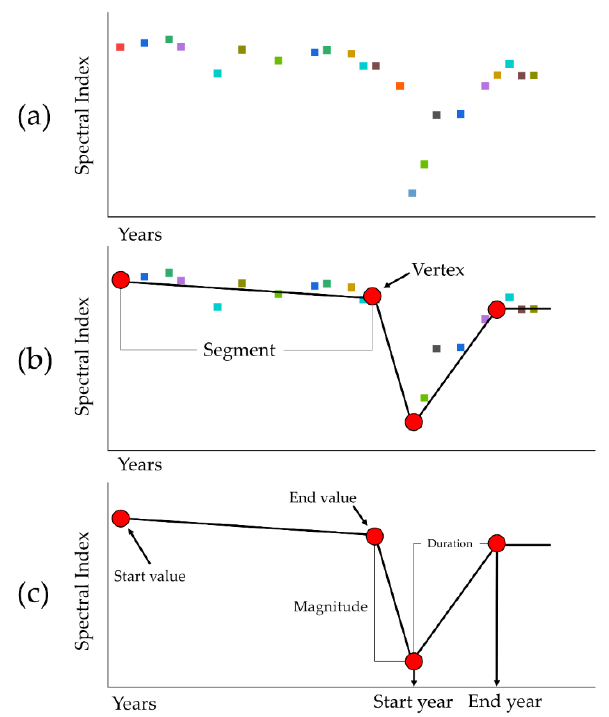
Figure 6. LandTrendr pixel time-series segmentation [42]. ( a ) Time series of individual bands or spectral indicators of image elements. ( b ) Segmentation into a series of linear segments by identifying vertices. ( c ) Significant features of each segment of the indicator trajectory.